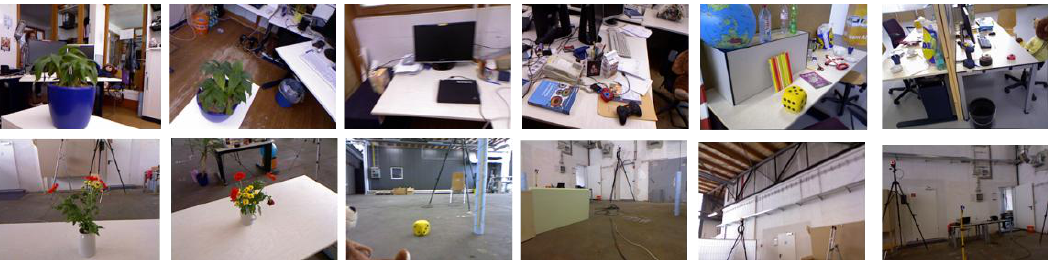
Figure 8. Images in TUM RGB-D dataset.